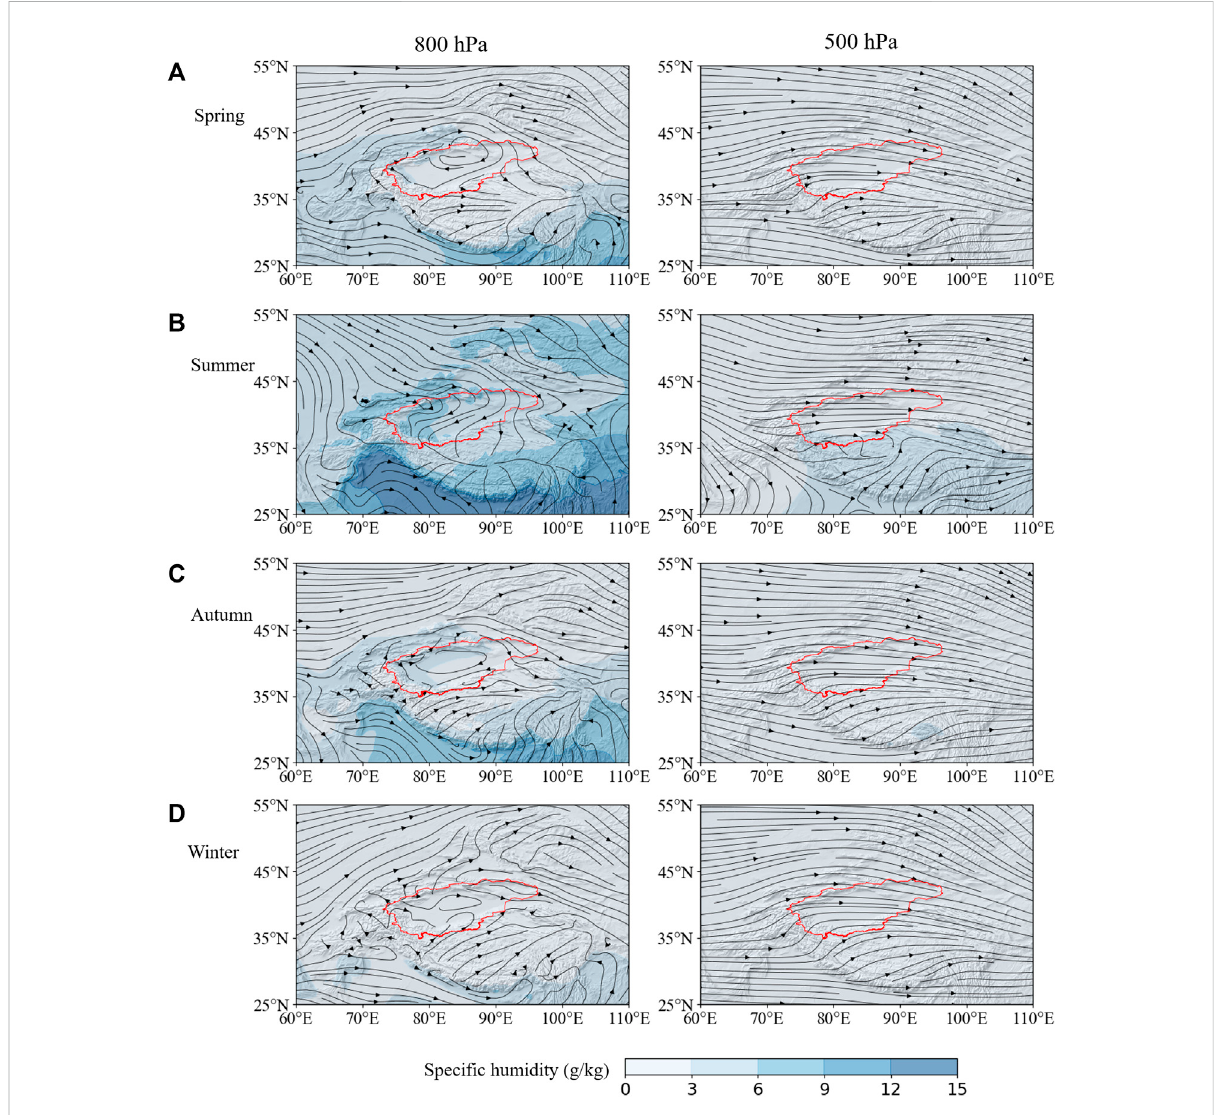
supposed evapotranspiration increase as Scenario I to III (see Table 1). The baseline value of multi-year